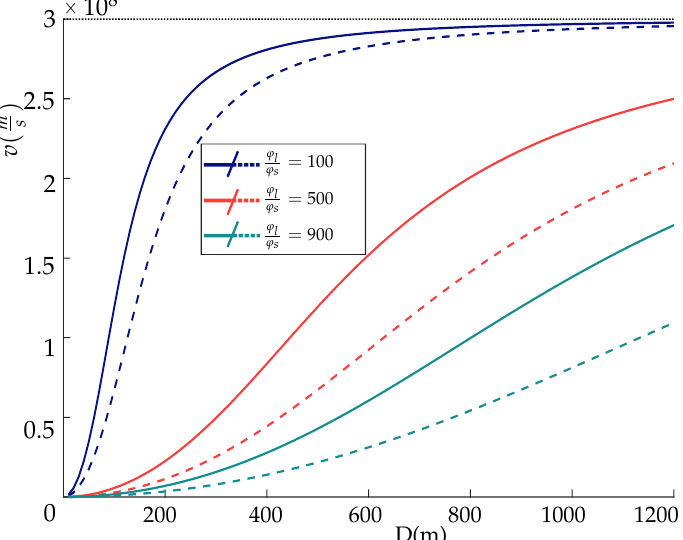
Figure 6. Steeped Leader Speed as function of the diameter for different ϕ l λ = 5000 Ω while dotted lines are for λ =10,000 Ω